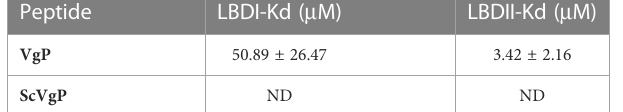
TABLE 3 Af fi nity data from micro scale thermophoresis experiments.